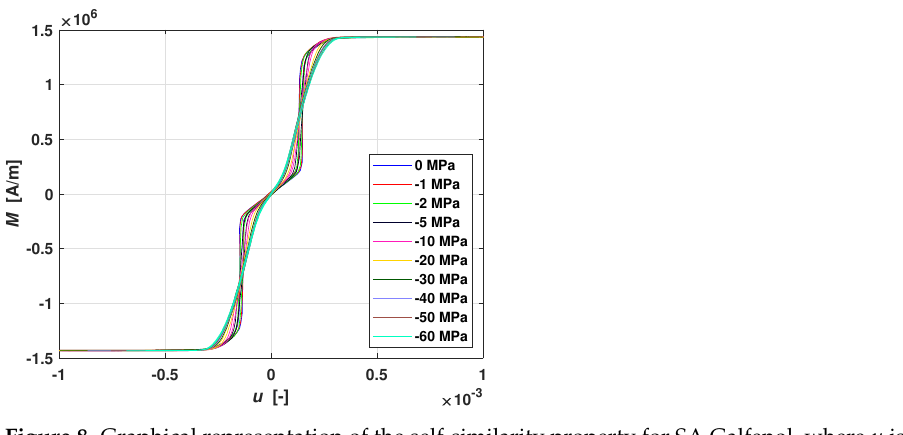
Figure 8. Graphical representation of the self-similarity property for SA Galfenol, where u is defined as in Equation (16) but with β = − 1.313 × 10 − 3 and σ 0 = − 35